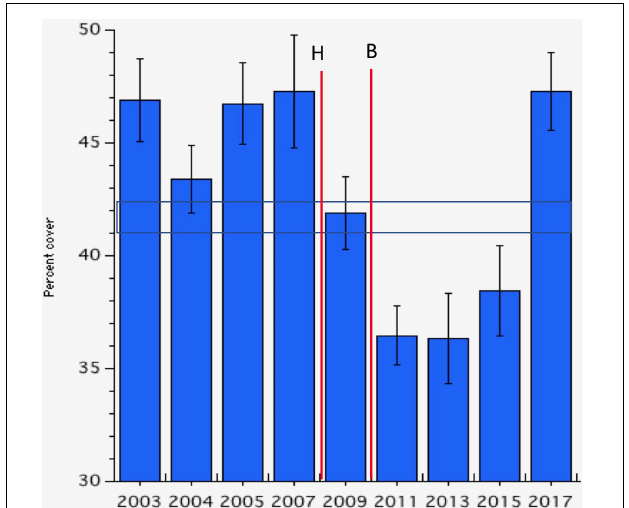
FIGURE 2 | Mean percent cover of live coral at monitored sites (variance here and throughout is expressed as standard error). The horizontal lines illustrate one standard error of the mean over the period. Vertical lines labeled “H” and “B” denote Hurricane Omar (October 2008) and the severe coral bleaching event of October 2010, respectively. For comparison, the average coral cover in the Eastern Caribbean was (17.6% ± 1.9 SE; Steneck et al., 2018 and see below).